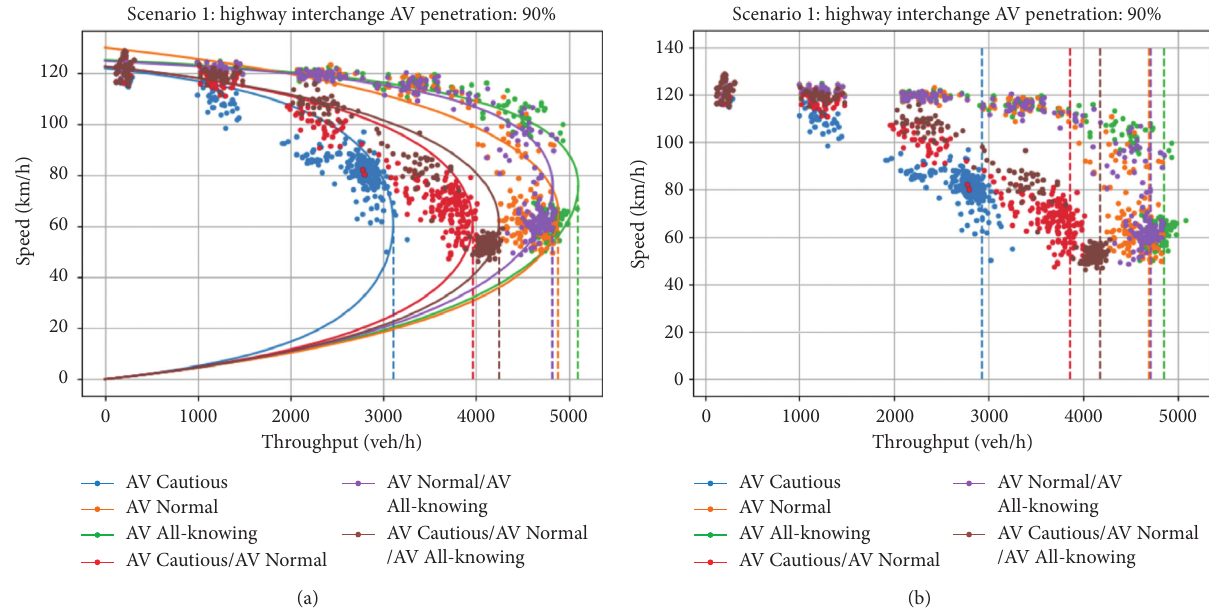
Figure 5: Example of van Aerde diagrams (a) and the 95% quantile (b) for the flow-speed relationships derived from simulations of a two- lane motorway with a one-lane off-ramp and on-ramp for an AV penetration rate of 90% of either the Cautious, Normal, All-knowing, and combined logics. For cases with mixes of driving logics, the shares of the AV logics are equal, e.g., 50/50 and